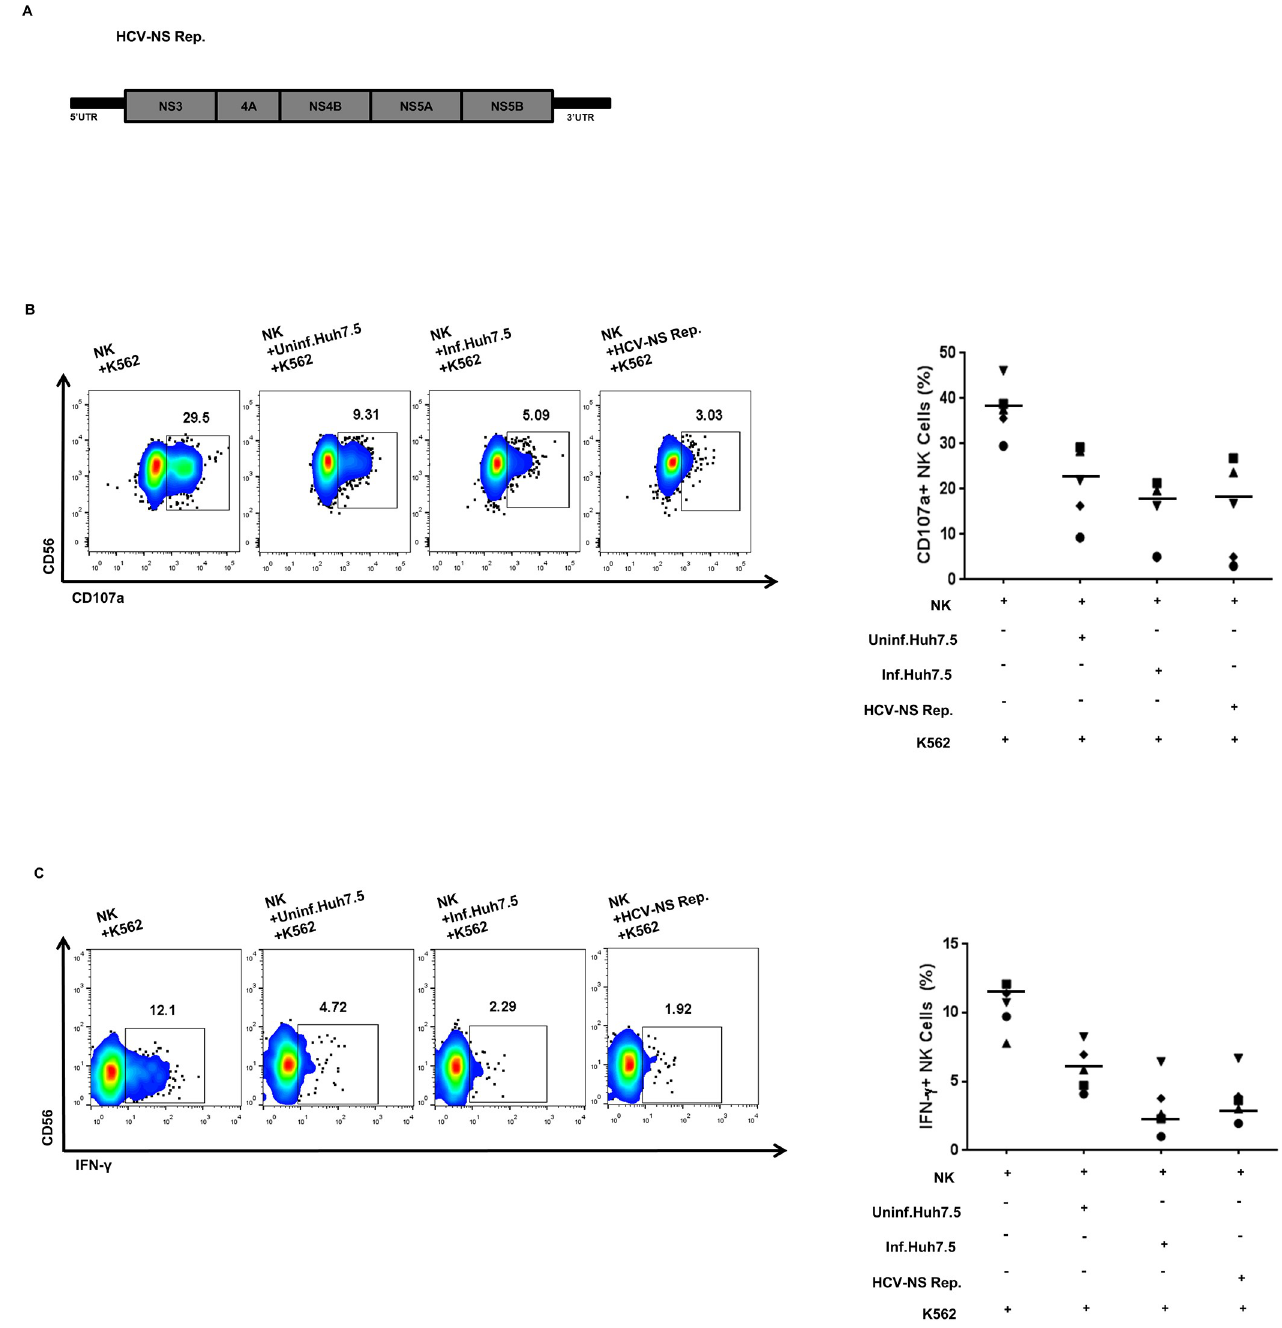
Fig 1. Hepatitis C Virus-Non-Structural (HCV-NS) protein-expressing cells reduce Natural Killer (NK) cell cytotoxicity and Interferon (IFN)- γ production. (A) Schematic diagrams of the HCV–NS repliconconstructs. (B) Degranulationof NK cells after co-cultivation with HCV- infected Huh-7.5 cells or HCV–NSrepliconcells. NK cells were pre-incubated with HCV-infected Huh-7.5cells or HCV-NS replicon cells for 18 h, and harvestedthe NK cells then co-culturedwith K-562 cells at a 1:1 ratio for 4 h. NK cell degranulation was measured by estimatingCD107a expression. (C) IFN- γ productionby NK cells after co-cultivation with HCV-infectedHuh-7.5cells or HCV–NS repliconcells. NK cells were pre- incubatedwith HCV-infected Huh-7.5cells or HCV-NS repliconcells for 18 h, and harvestedthe NK cells then co-cultured with K-562 cells at a 1:1 ratio with treatment of 10 ng/mL recombinant humaninterleukin(IL)-12 and 100 ng/mL IL-15 for 6 h. IFN- γ production was assessed by intracellular stainingof IFN- γ followedby flow cytometry. (B-C) Representative pseudocolor plots obtained for five independentindividuals.Bar presents the